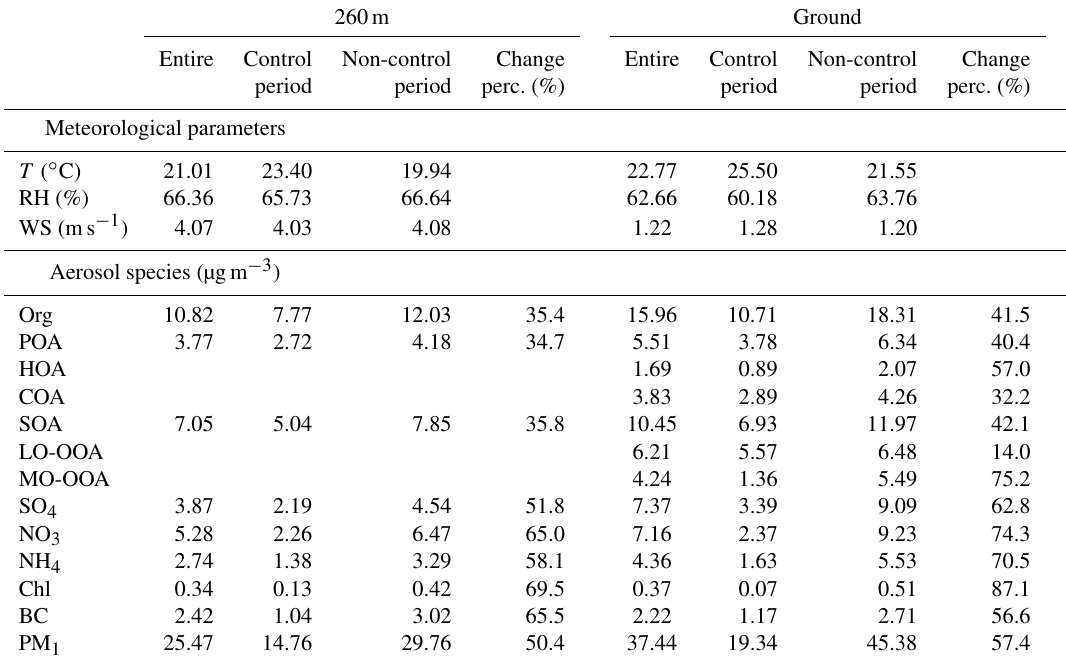
Table 1. Summary of average meteorological parameters and chemical compositions during and after the control period, and the entire study at ground level and 260m. Change percentages in mass concentrations of PM 1 species during and after the control period are also shown. 260m Ground Entire Control Non-control Change Entire Control Non-control Change period period perc. (%) period period perc. (%) Meteorological